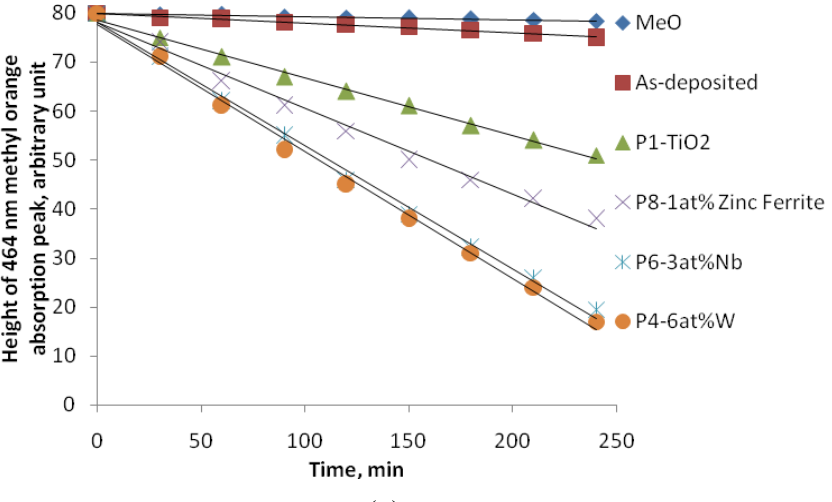
Figure 4. Degradation of 464nm methyl orange (MeO) absorption peak as a function of exposure time to ( a ) UV lamps; ( b ) fluorescent lamps for titania samples P1 (pure titania for comparison), P4, P6 and P8, annealed at 700 ° C, compared to an as-deposited coating and MeO without the presence of a photocatalyst. Linear regression analysis trendlines are